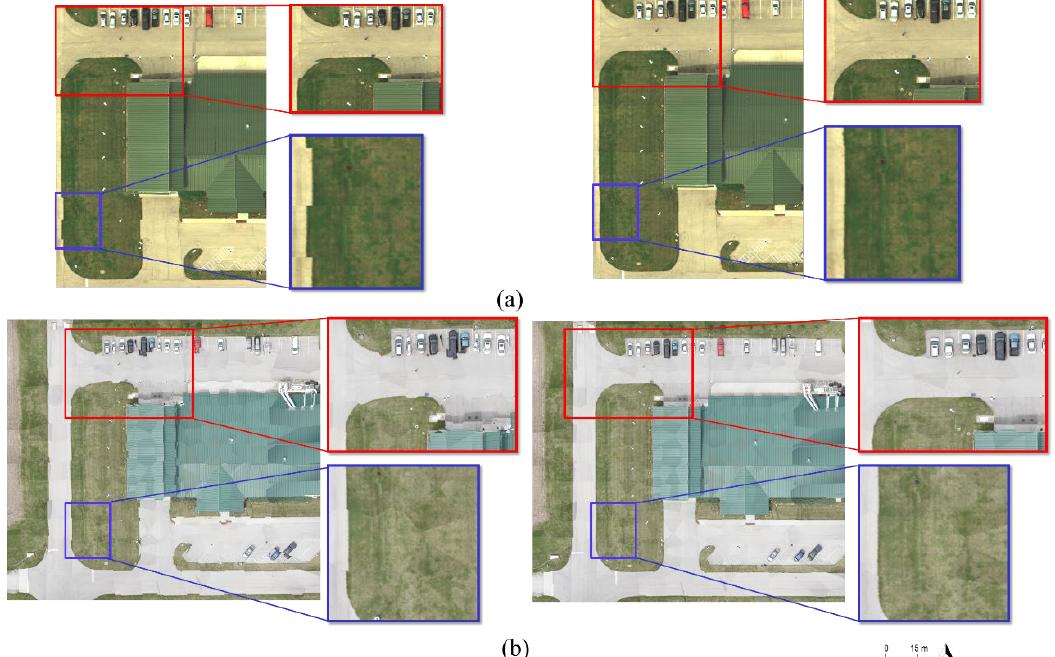
Figure 8. Orthophotos generated from nominal (left) and estimated boresight angles (right) for the Building dataset: (a) HS orthophotos and (b) RGB